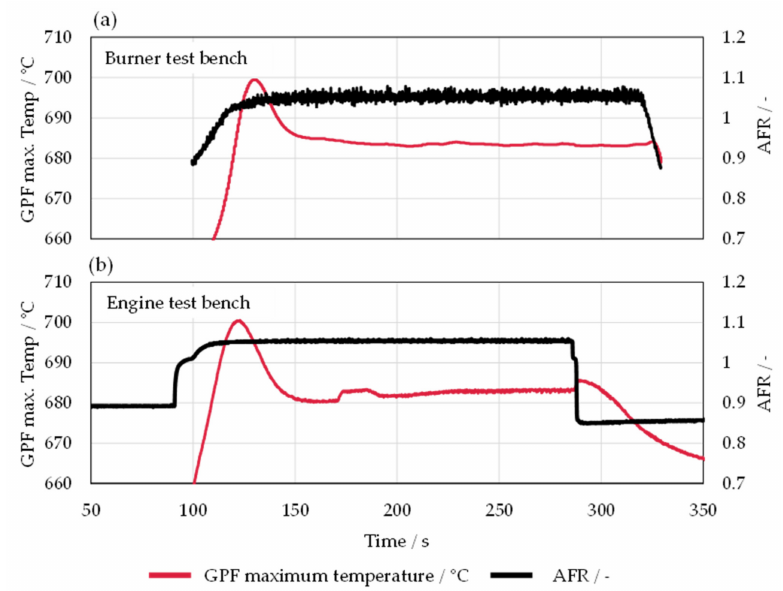
Figure 14. GPF temperature and AFR for an active regeneration event—burner test bench ( a ) vs. engine test bench ( b